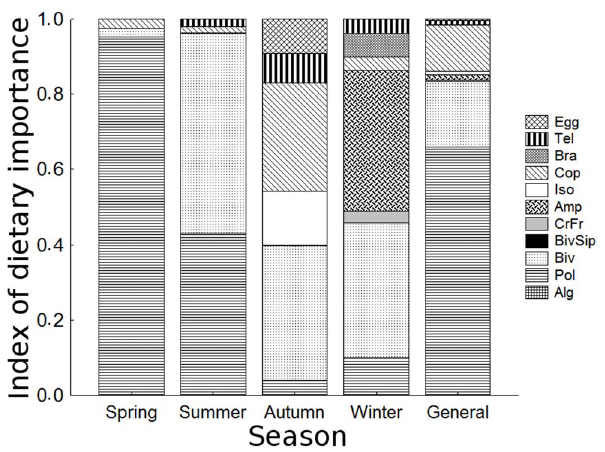
Figure 5. Index of dietary importance for each prey group. Index of dietary importance (IAi) for each prey group found in the stomach contents of Cathorops spixii collected in Caraguatatuba Bight from August 2003 through October 2004. Values are given by season and overall. Abbrev. : Polychaeta (Pol), Bivalvia (Biv), Copepoda (Cop), Amphipoda (Amp), Isopoda (Iso), Teleostei (Tel), unidentified crustacean fragments. (CrFr), Bivalvia siphons (BivSip), Algae (Alg).